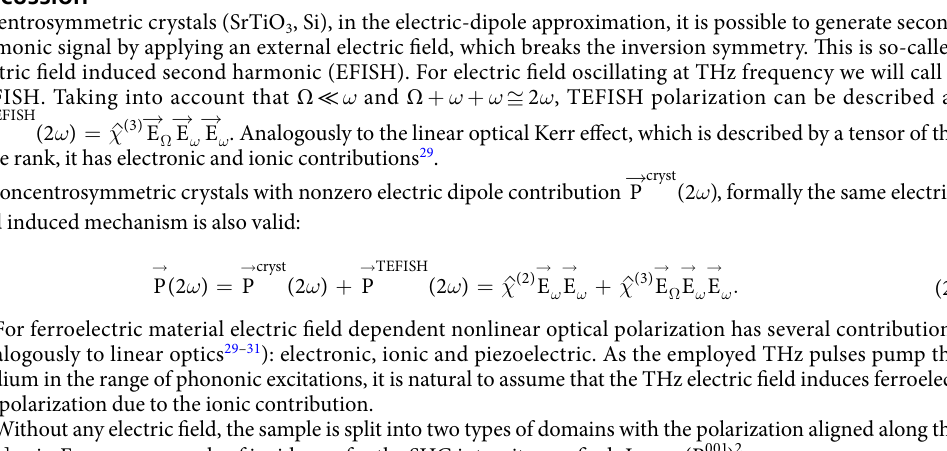
from the residual signal. It gives the value, which is proportional to the electric polarization P 0 + P(E Ω ). The result of such a data processing is shown in Fig. 3a (top solid line). Additionally, we can mirror the loop with respect to the x-axis at negative electric fields and thus obtain a loop that resembles largely the dielectric hysteresis loop obtained in statics (Fig. 3a, dashed line). Since in the THz measurements both electric field and SHG intensity are measured as a function of time, hysteresis loop is set parametrically. After excluding time from these dependences and performing the same procedure for the SHG intensity (except taking the square root because of linear dependence of the SHG intensity), the THz SHG loop is obtained. In Fig. 3a points show hysteresis loops for two values of the THz electric field (E-field). Although these loops are quite noisy, a similarity with the low-frequency loop (with hysteresis and coercively) is obvious.